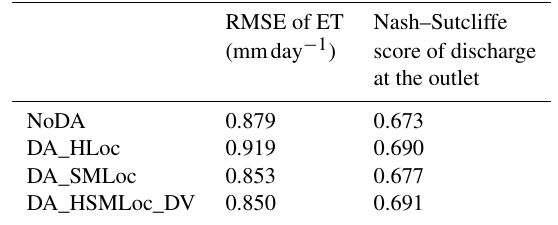
Table 5. Quantitative performance measures for evapotranspiration (ET) and discharge for each experiment in the Ahlergaarde catch-